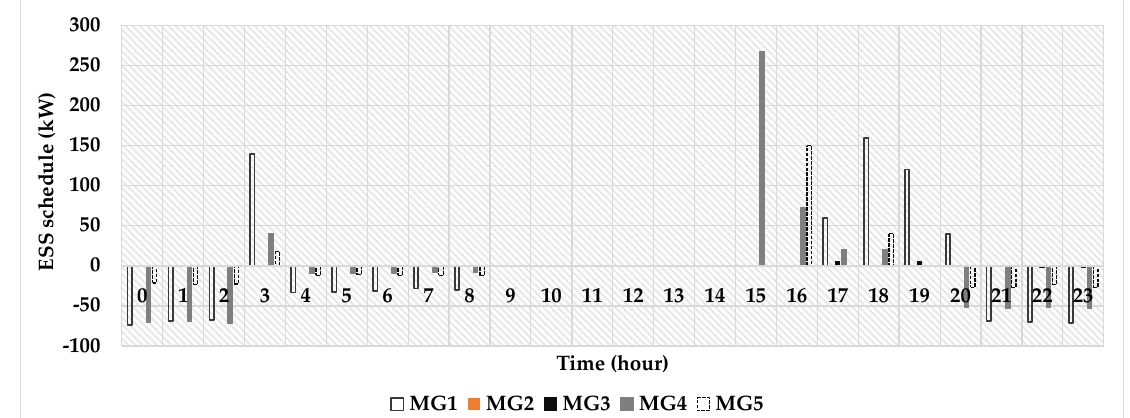
Figure 9. ESS scheduling considering the power sharing scheduling.